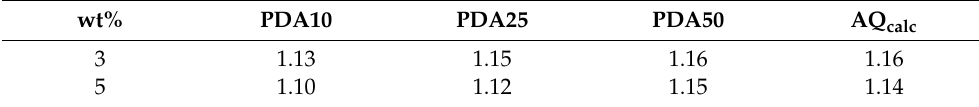
Table 1. IEC values (meq g − 1 ) of PDAx@CeO 2 composite membranes. The IEC values calculated based on the Aquivion wt% (AQ calc ) are also